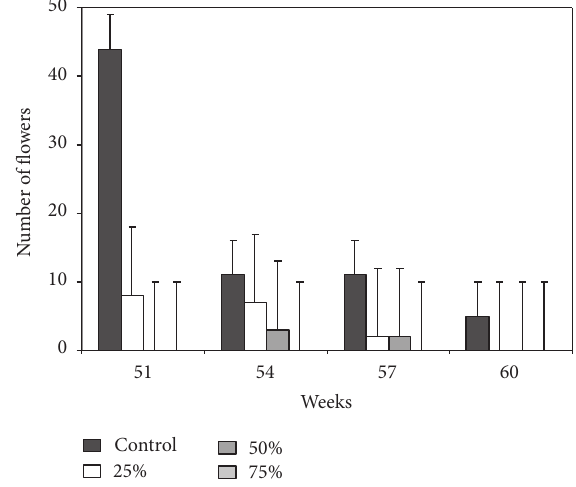
Figure 6: Pattern of flowering of T. daniellii in response to foliage harvest over 12 weeks.